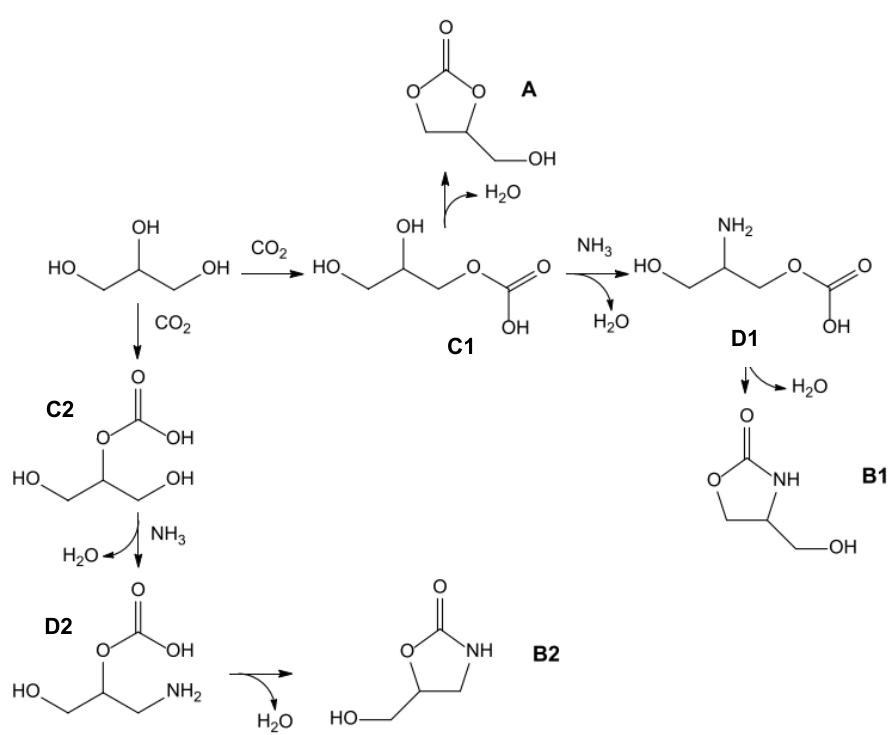
Figure 7. The proposed reaction pathway for carboxylation of glycerol to glycerol carbonate and by-products [1].